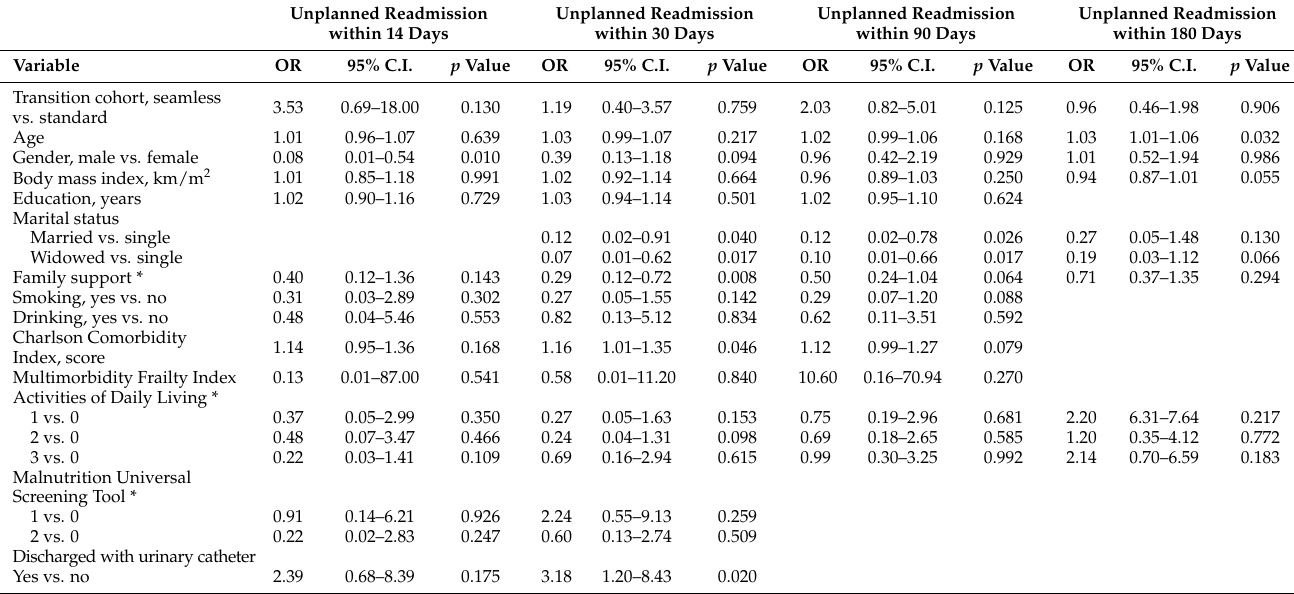
Table 3. Multivariate analysis of unplanned readmission after discharge: comparison of the two cohorts after adjustment for patient study characteristics.